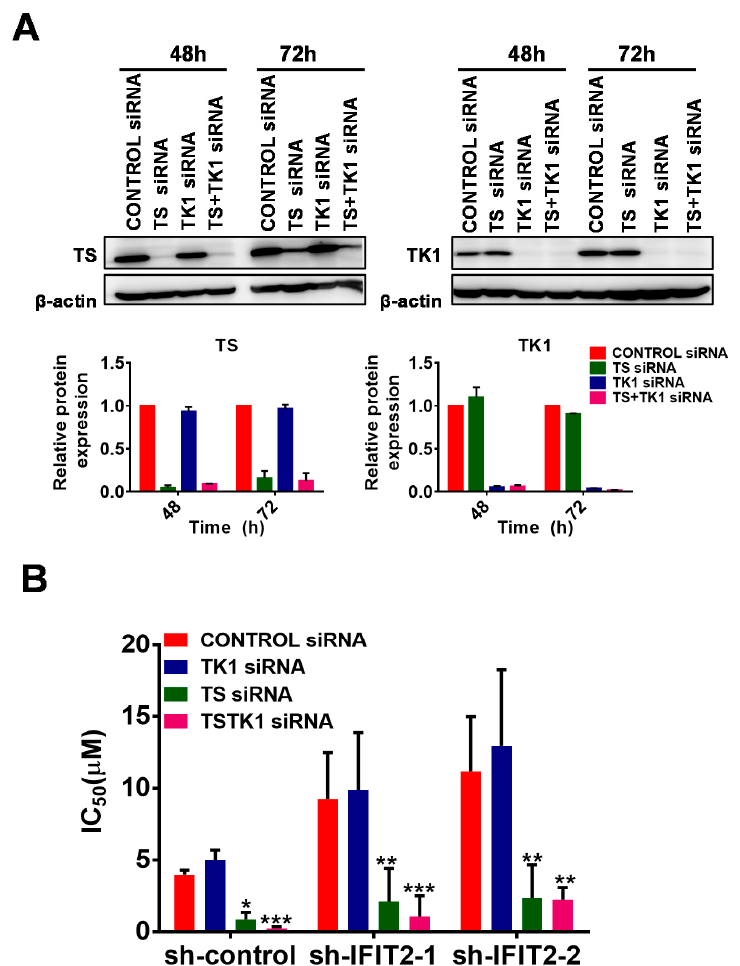
Figure 5. Silencing TS expression sensitizes IFIT2-knockdown cells to 5-FU. ( A ) Silencing TS or